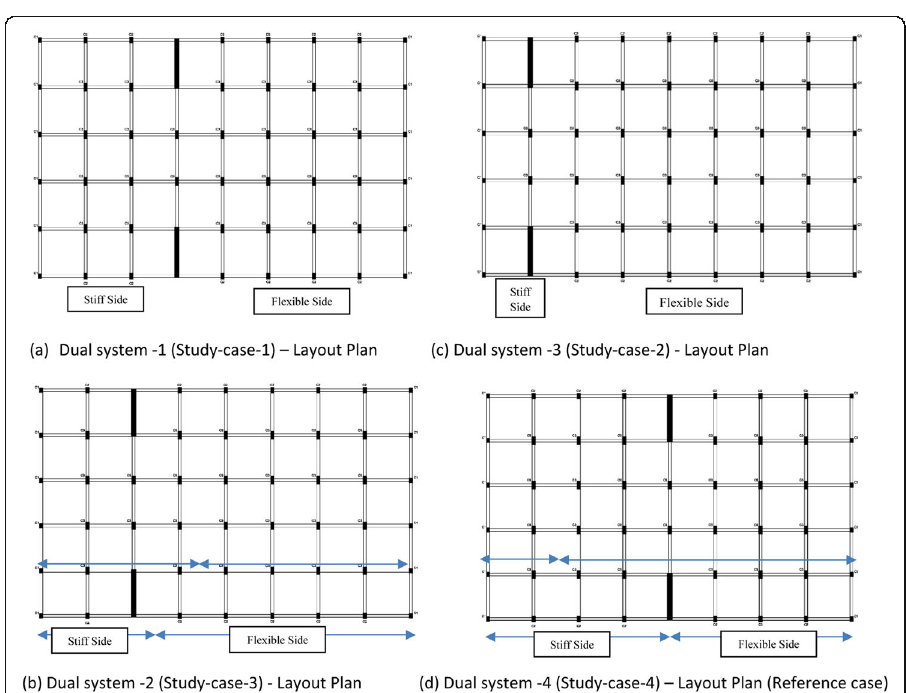
Fig. 16 Study — cases reinforcement plans. a Dual system-1 (study-case-1) — layout plan. b (b)